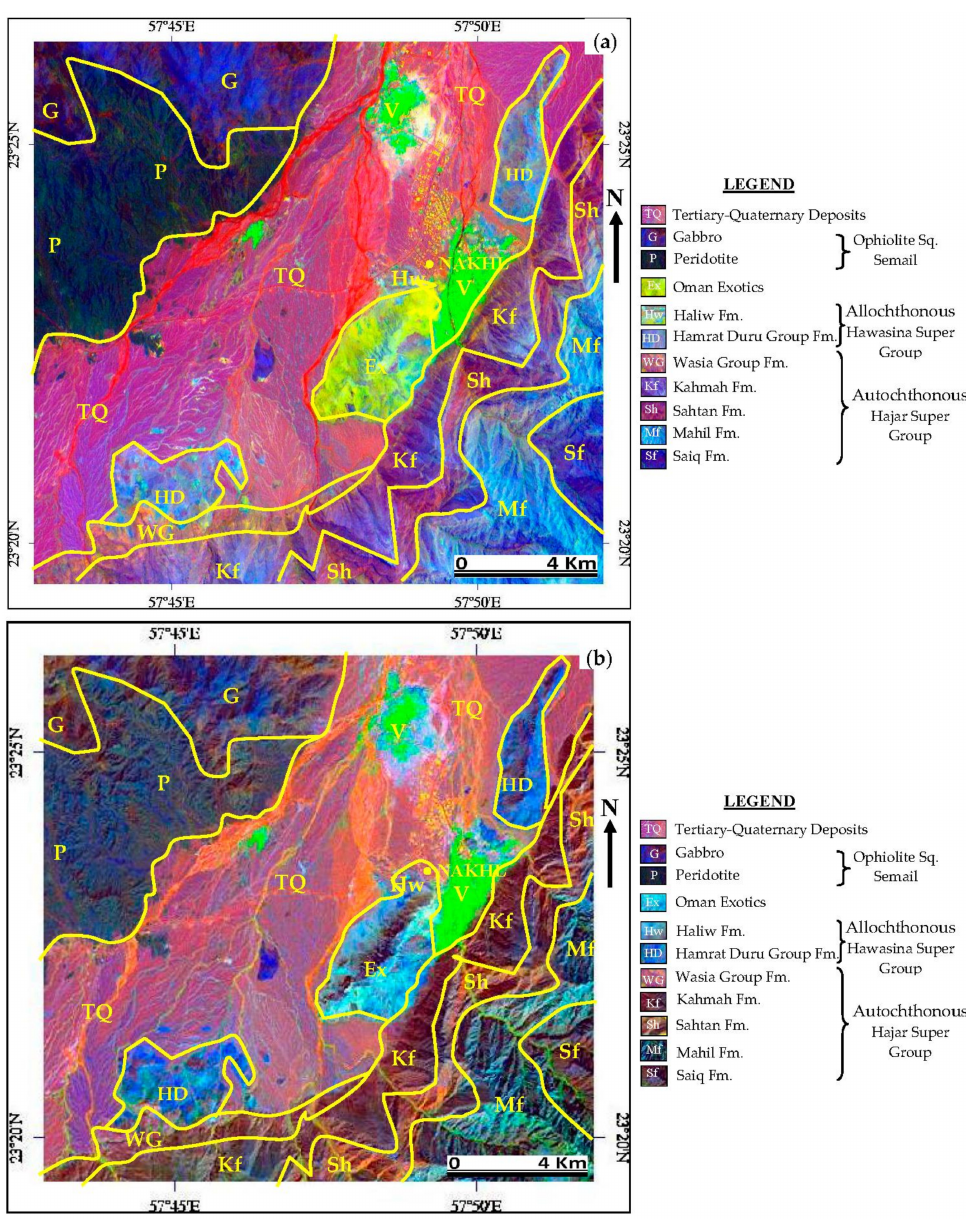
Figure 3. Decorrelated images of ( a ) the spectral bands 8, 3 and 1 of ASTER and ( b ) the 7, 4 and 2 of Landsat ETM+ show the occurrences of exotic limestone and other formations of the Nakhl